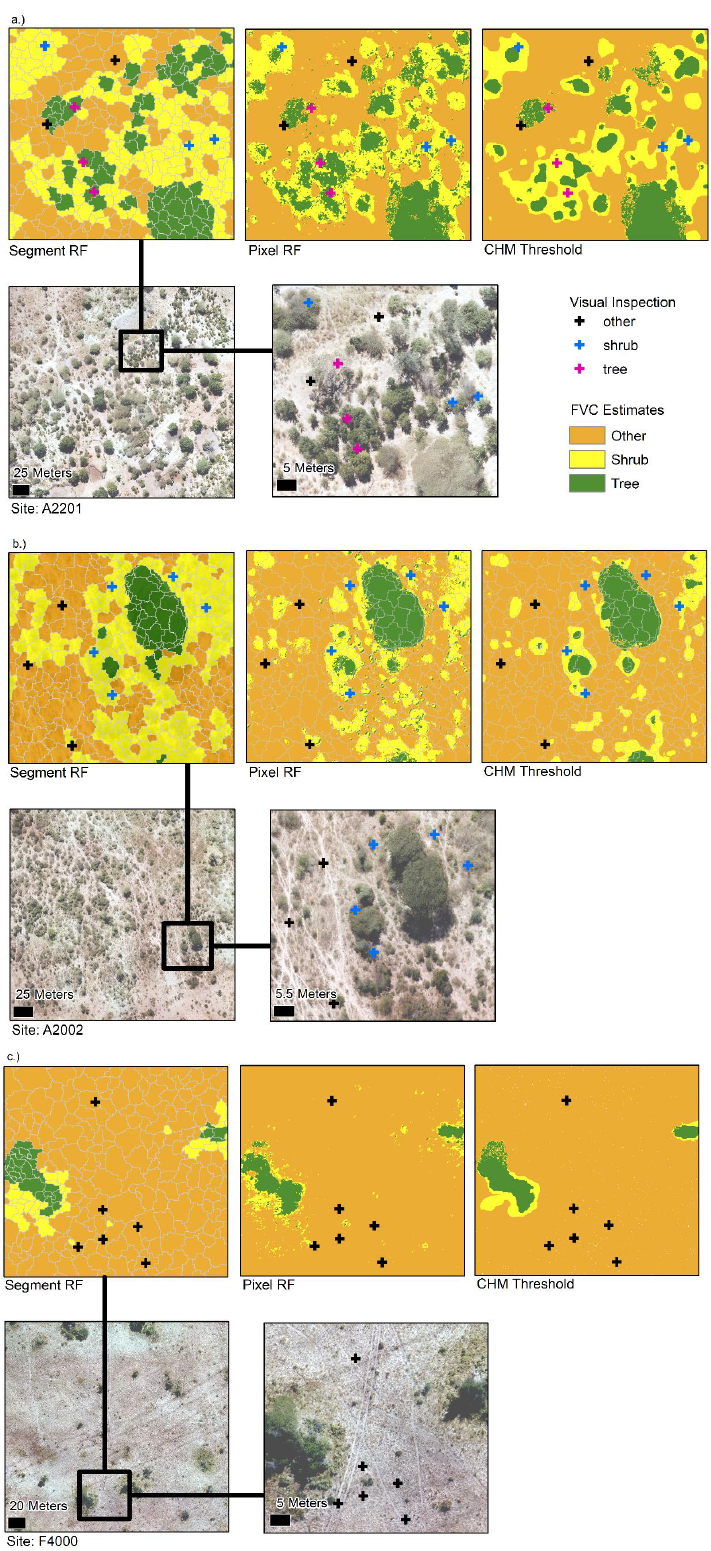
Figure 4. Classified maps for site types ( a ) woody, ( b ) shrub, and ( c ) other. Segments are overlaid on the predicted S-RF output. Black crosses represent visual inspection points that fall within each site area. The site area imagery and the inset (~4 cm nominal ground resolution) are also displayed for each using the Mavic orthomosaics. Table 2 quantitatively compares the classification results across the class-balanced set of held-out reference points for each classification approach (the complete, unbalanced validation data are presented in Table S1). The quantitative metrics outlined in the meth- ods show that, at the reference point level, the P-RF has the highest overall agreement. Examining only the error matrix for each classifier, “ tree ” and “ shrub ” points were more likely to be misclassified than the “ other ” class. The quantity metric showed the most change in the CHM threshold approach between the classified map and reference points. This directly relates to the exchange, or confusion, between “ shrub ” and “ other ” borne out in the error matrix. The RF-based classification showed higher quantity disagreement with the segment-based approach than the pixel-based approach, but both RF-models showed more confusion in the exchange and shift metrics when compared to the CHM threshold approach. Table 2. Classification assessment output for ( a ) P-RF, ( b ) S-RF, and ( c ) threshold techniques for quantifying fractional vegetation coverage. (a) Pixel-Based RF (P-RF) Error Matrix Unweighted Other